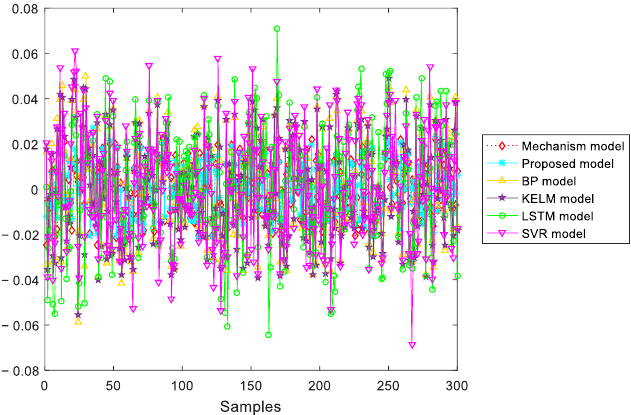
Figure 5. Comparison of actual concentration and predicted concentration for different models when the data fluctuate greatly.